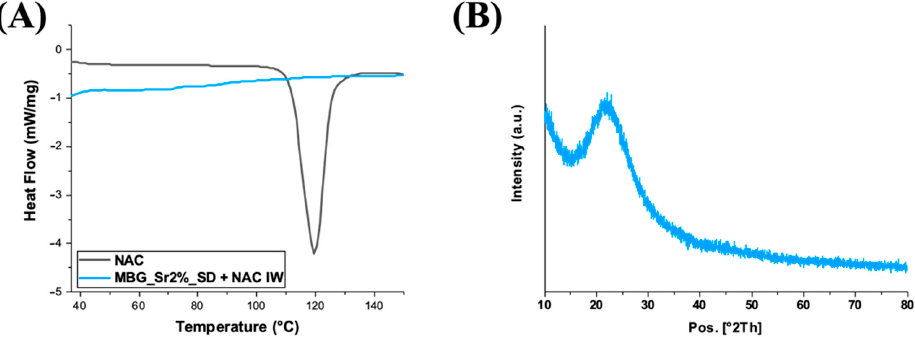
Figure 10. ( A ) DSC thermograms of NAC compared to MBG_Sr_NAC and ( B ) the XRD pattern of MBG_Sr_NAC.